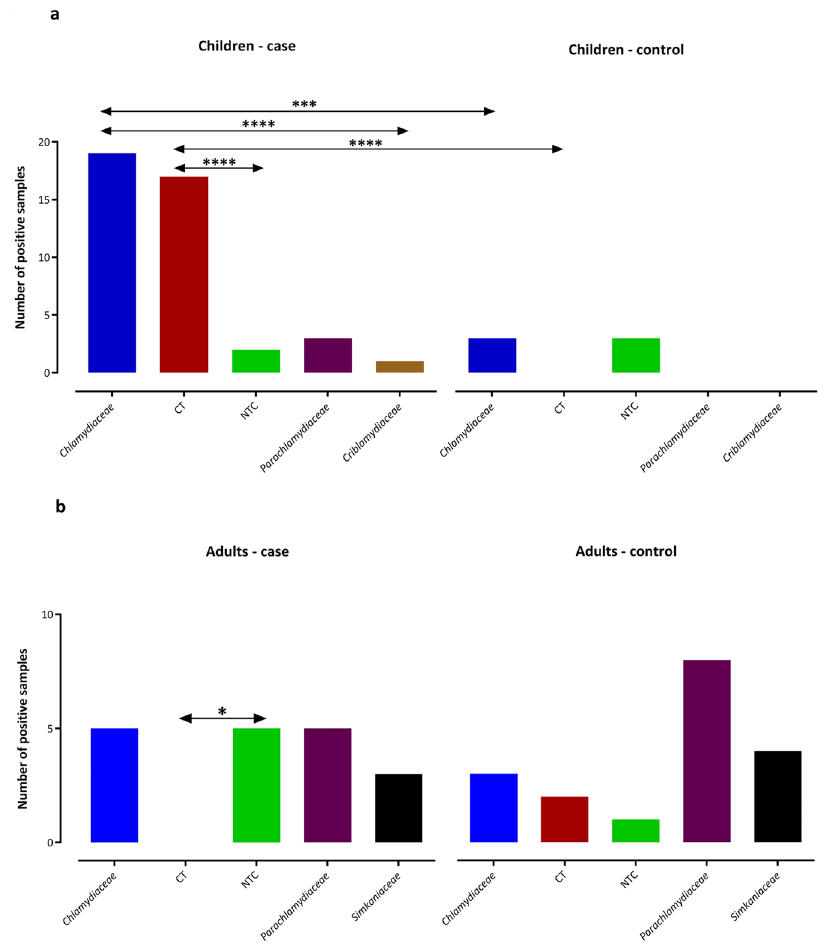
Figure 7. Distribution of 16 S rRNA gene sequences assigned to families in the phylum Chlamydiae , C . trachomatis (CT), and non- trachomatis Chlamydiaceae (NTC) among ( a ) children and ( b ) adults. Prevalence of classified sequences as CT in the children case group was significantly higher than that in the children control group. The statistical significance is indicated as follows: * p < 0.05, *** p < 0.001, and **** p <